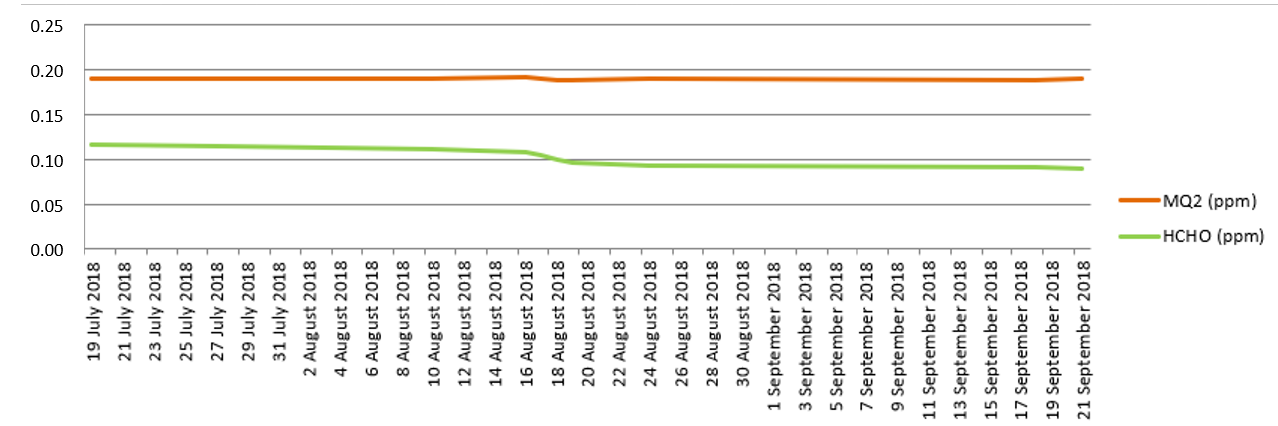
Figure 10. Linear graph of the monitoring of data from the VOC sensor (volatile organic compounds). Curve in green is relative to the MQ2 data and in red relative to the HCHO data.